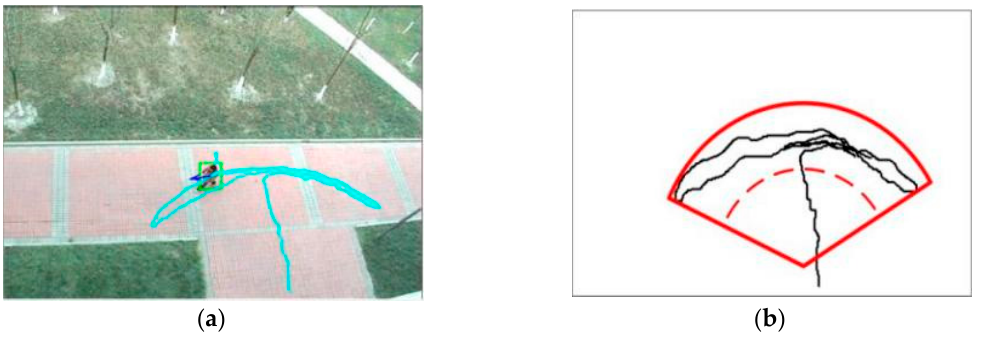
Figure 4. Sector loitering. ( a ) The loitering in the real scene. ( b ) Sector loitering trajectory simulation map.